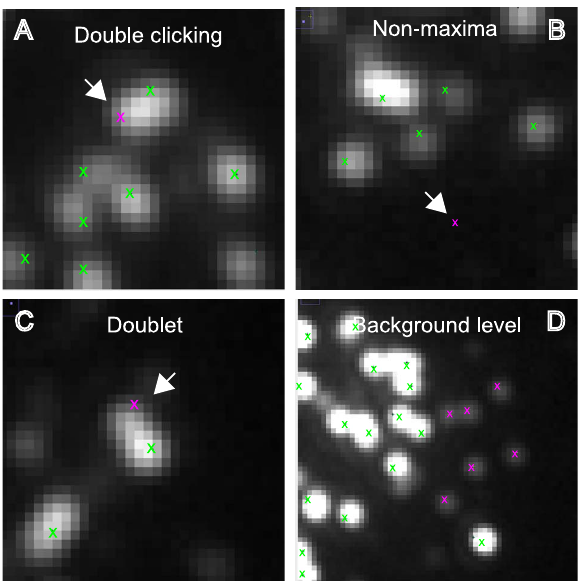
Figure 3. Sources of inconsistency in focus selection between experimenters. Matches are shown in green and unmatched points in magenta. (A) Dual assignment of a single maximum by experimenter 2 (‘double clicking’); (B) mislabelling of non-true maxima; (C) interpretation of diffraction-limited foci as a single focus or dual foci (‘doublet’); and (D) arbitrary selection of different background levels to determine inclusion of foci in the analysis. Arrows indicate the discordant foci in